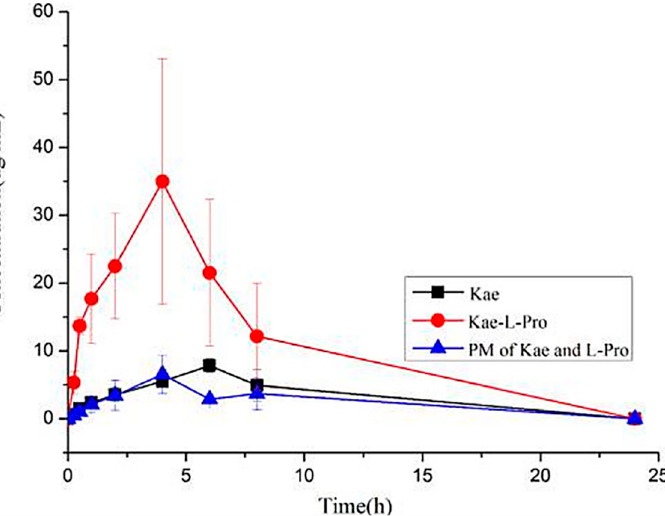
Figure 10. Pharmacokinetic profiles of Kae-3- O -glucosylside after administration of kaempferol (Kae), kaempferol-L-proline (Kae-L-Pro) and physical mixture (PM) of Kae and L-Pro (mean plasma concentration versus time). Data are expressed as means ± SD, n = 6. Adapted from [58] with permission. Copyright © 2016 American Chemical Society.